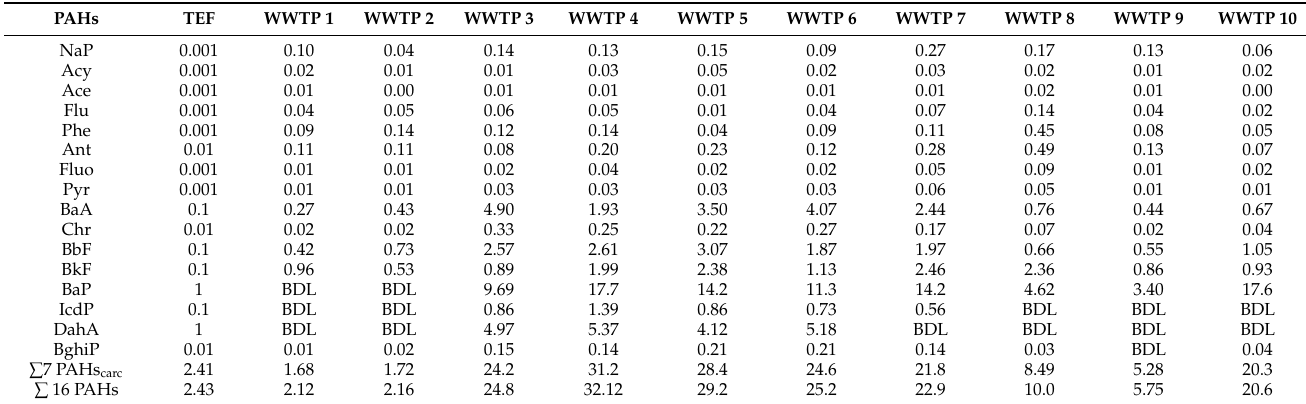
Table 3. PAHs TEQ concentrations in different WWTPs µ